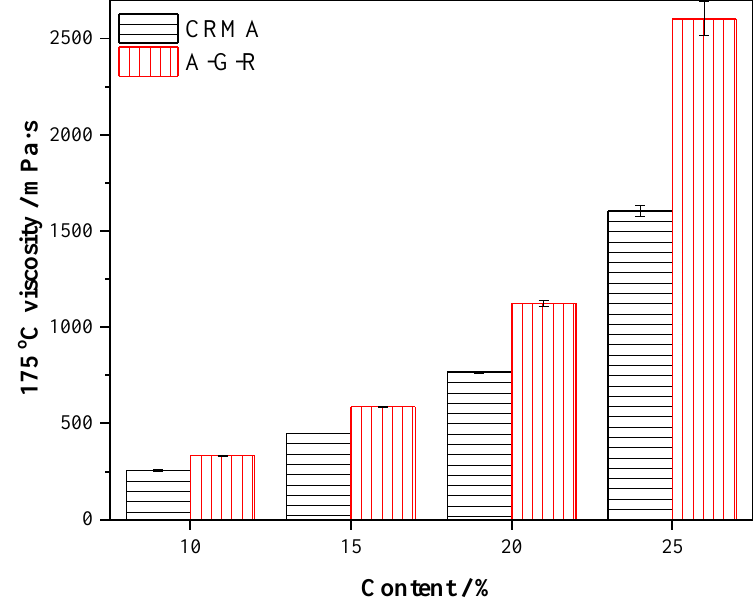
◦ C viscosity of CRMA and Figure 5. The 175 °C viscosity of CRMA and A–G–R. Figure 5. The 175